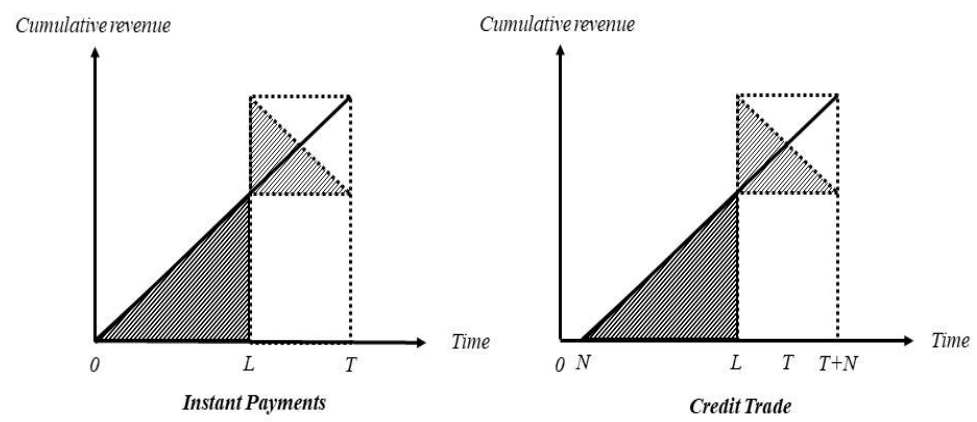
Figure 1. Graphical representation of L ≤ T .